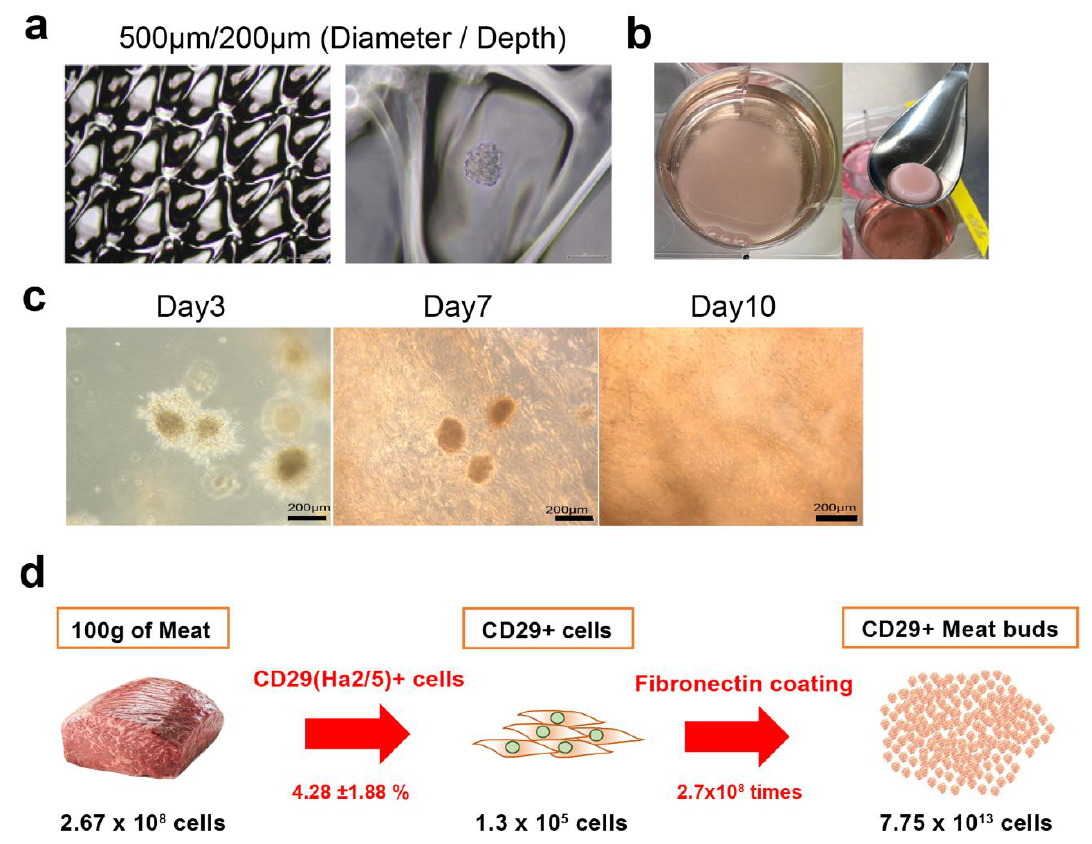
Figure 5. Construction of collagen gel tissue incorporating bovine meat buds. ( a ) Photographs of mass culture of micro- spheroids by spheroid generation plates. Well diameter/depth (500/200). ( b ) Culture of collagen gel incorporating Ha2/5 meat buds. Collagen gel after 24 h (left) and three days (right). ( c ) Phase photographs of the incorporated Ha2/5 meat buds are shown. Time course of collagen gel incorporating Ha2/5 meat buds. Phase photographs of the incorporated spheroids are shown. The scale bar represents 200 μm. ( d ) Calculation of how many meat buds can be made from 100 g of meat in 21 days.